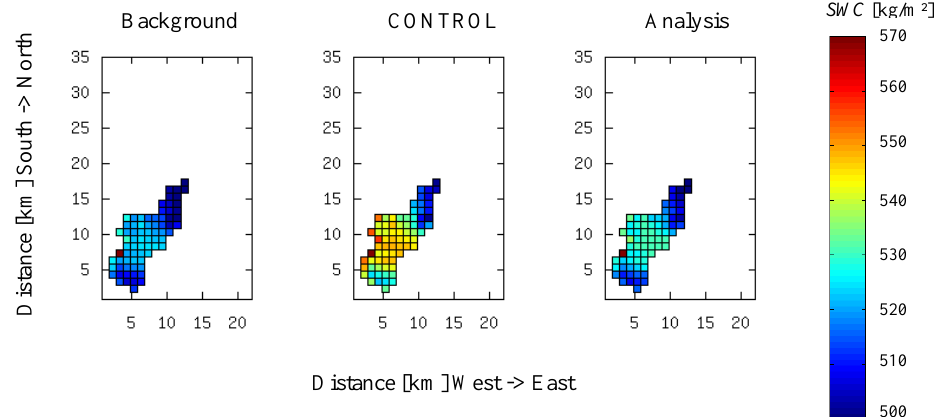
Fig. 13. TERRA-ML’s soil column is 2.43m deep. The soil-water content (SWC) of each grid cell depends on its soil depth and its soil moisture (Eq. 9). The SWC is displayed for the initial time t =0 (5 May 1997) for the background, CONTROL and analysis. The analysis at t =0 was obtained assimilating streamflow from the CONTROL model simulation from the Große Enz outlet from t =0 to t =34h with a 0.5 hourly timestep. Note that the scaling is different from Fig. 8.